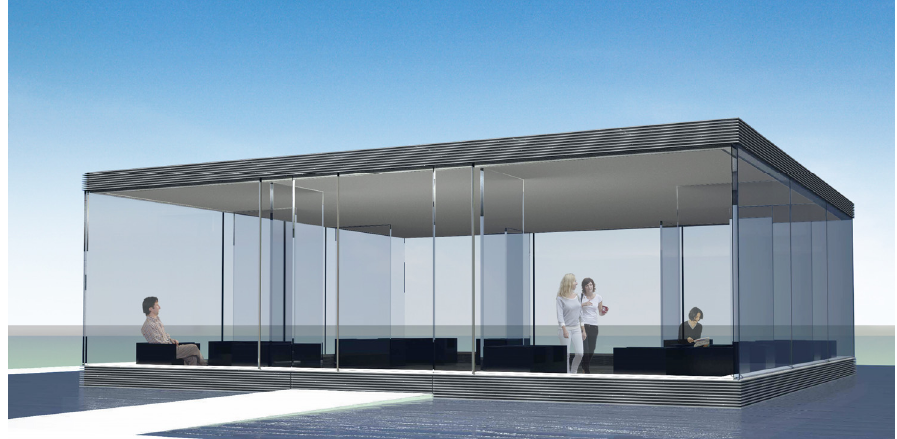
Figure 14: Kravis Center, Living Room (Rafael Vinoly Architects)